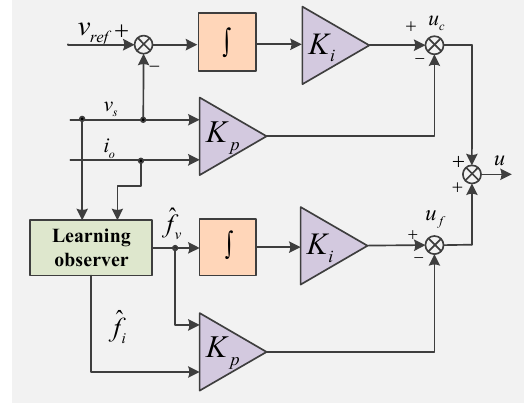
Figure 3. Fault ‐ tolerant controller. Figure 3. Fault-tolerant